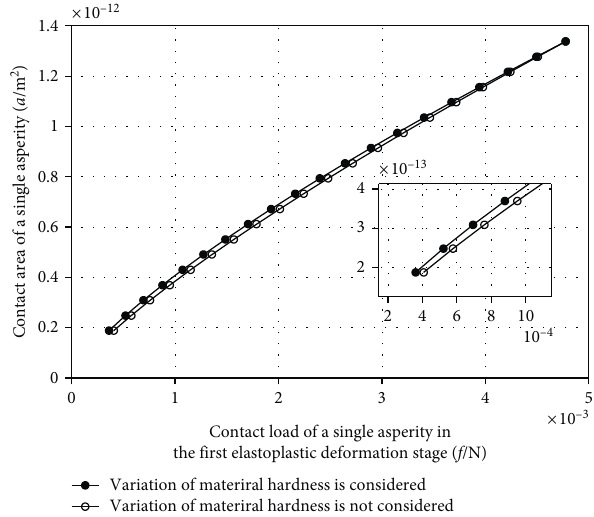
Figure 8: The contact load-contact area relationship of a single asperity in the first elastoplastic deformation stage ( n � 33, A A � 0 . r / a